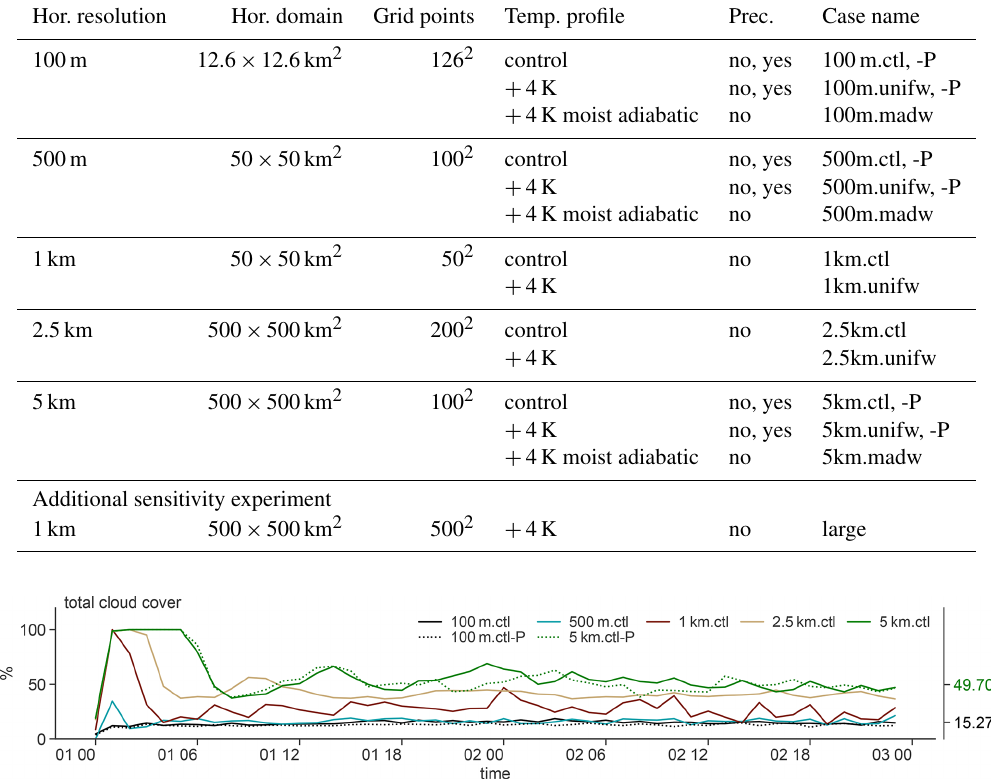
Table 1. Specifications used for the different perturbation experiments. Specific humidity in the perturbed runs (unifw and madw) is adjusted to keep the relative humidity constant compared to the control simulation. Hor. resolution